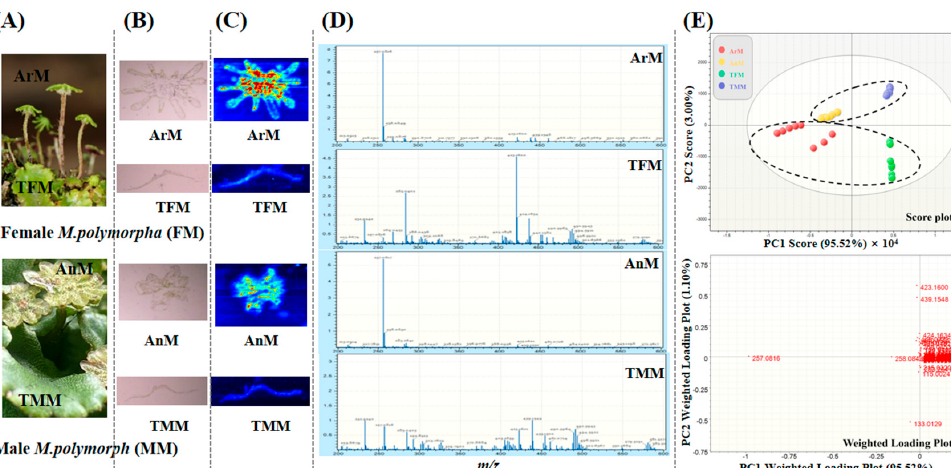
Figure 1. Multivariate statistical analysis for characteristic metabolites exploration of M. polymorpha using AFADESI. ( A ) Optical images of different plant parts of female and male M. polymorpha . ( B ) Optical images of cross sections of four parts (ArM, TFM, AnM, and TMM). ( C ) Negative mode AFADESI images of ArM, TFM, AnM, and TMM with the mass ranging from m/z 200 to 600. ( D ) Negative mode AFADESI mass spectra from ArM, TFM, AnM, and TMM. ( E ) PCA analysis of four parts from M. polymorpha .